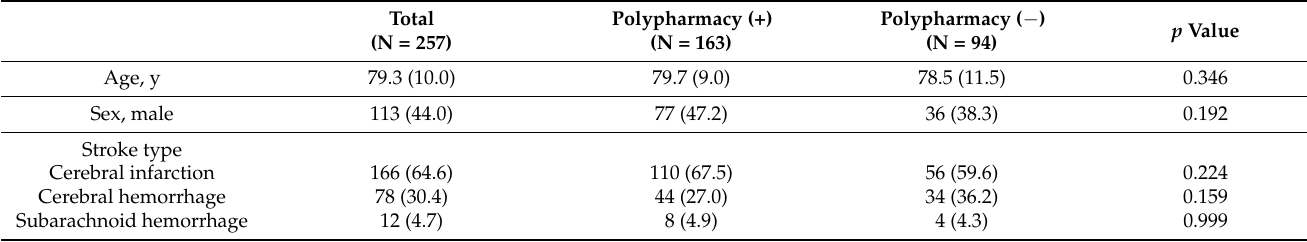
Table 1. Summary of baseline subject information and comparison between the two groups by presence or absence of polypharmacy at